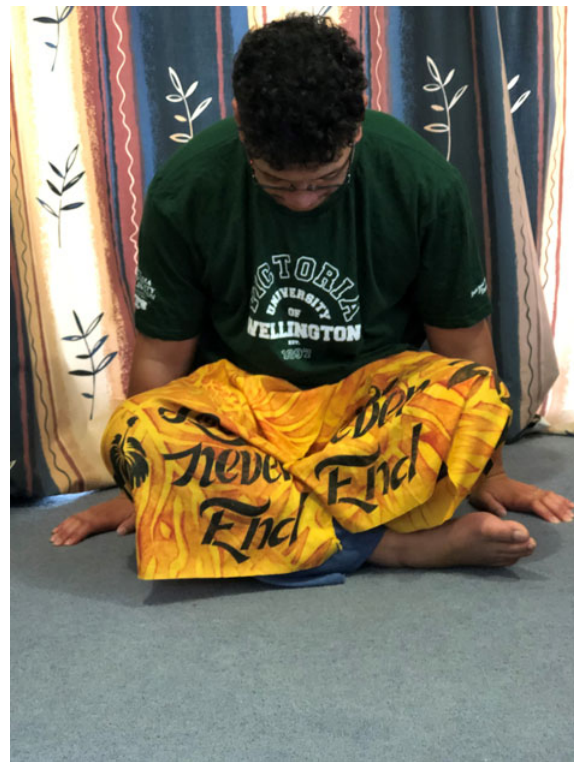
Fig. 2. Floor mirrored between pairs of performers, or by rows of performers, or between entire sections of the group. Discussion about the moves can include identifying the location of axes of symmetry, with rationale, predicting and designing movements that will